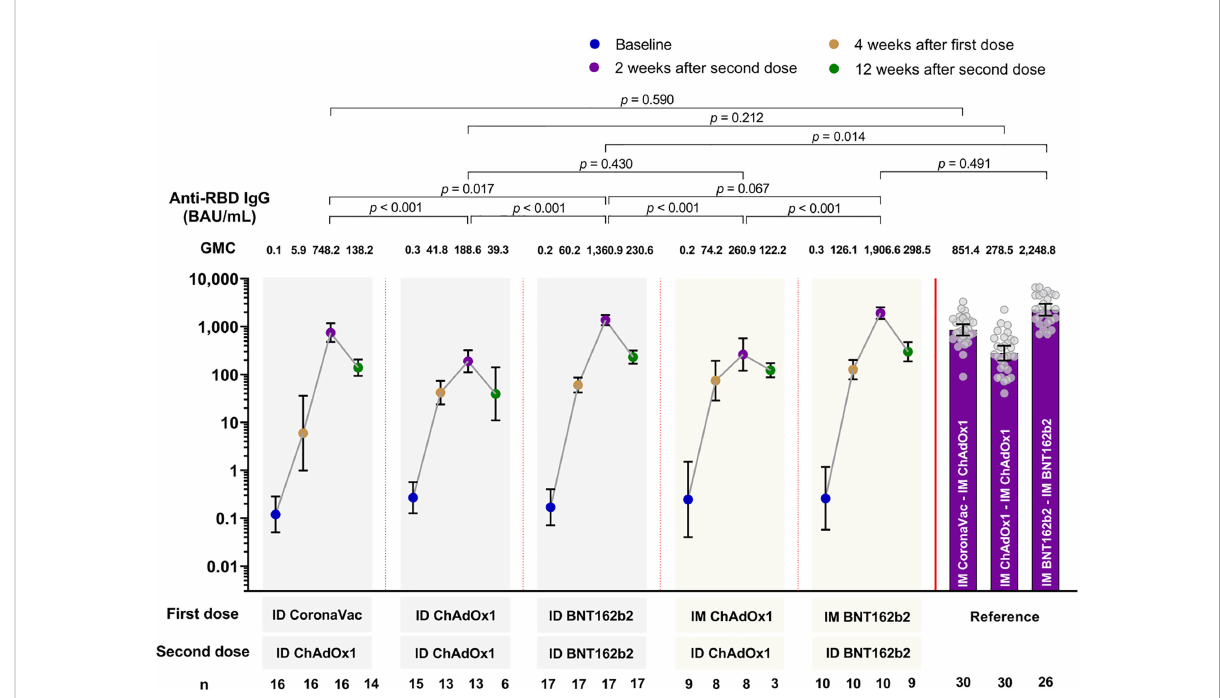
FIGURE 2 Geometric mean concentration of anti-RBD IgG at baseline, 4 months after fi rst dose, 2 and 12 weeks after second dose for all study arms. Data from IM-IM vaccine regimens serve as the reference group for comparison (9). Data presented as geometric mean concentrations (GMC) and 95% con fi dence intervals. P<0.05 is considered statistically signi fi cant. BAU, binding antibody units. n= number of